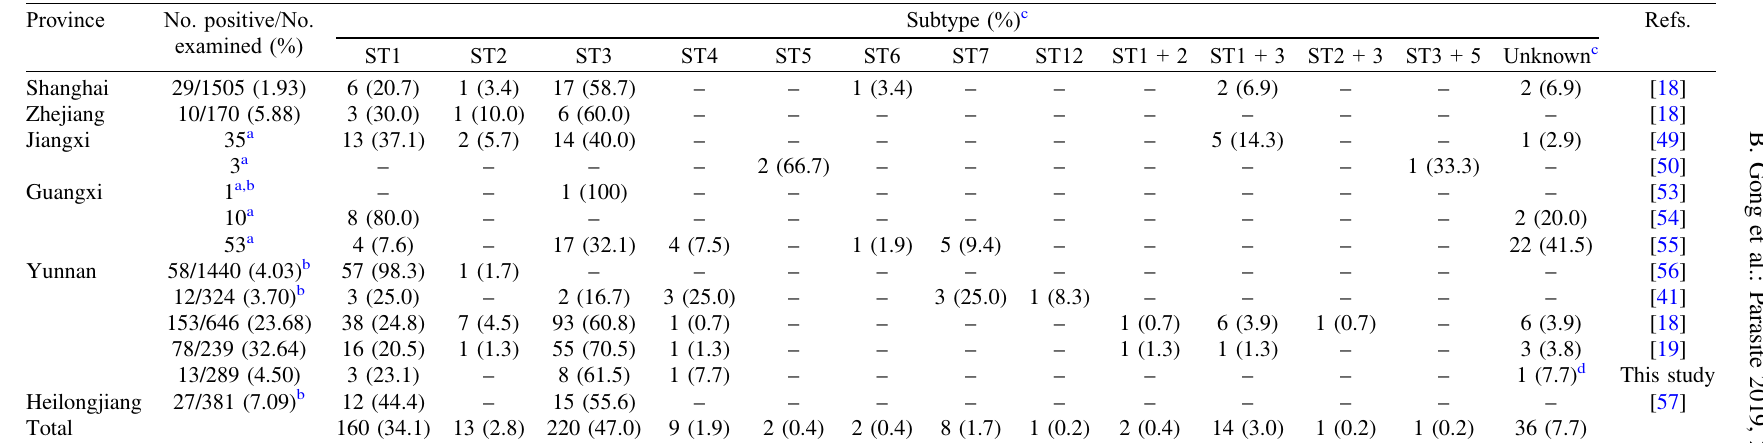
Table 4. Prevalence and subtype distribution of Blastocystis in humans by province in China. Province